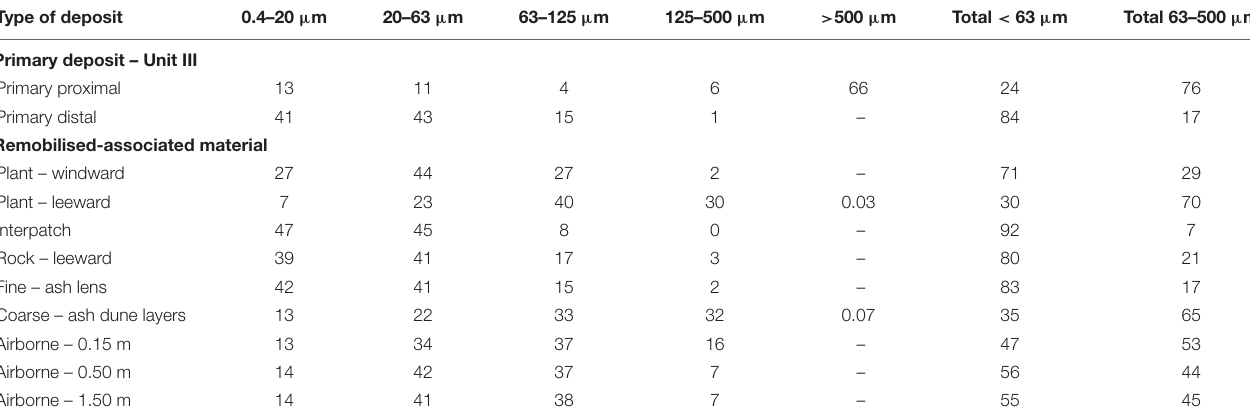
TABLE 3 | Averaged volume percentage (%) per grainsize class for primary tephra-fallout deposit and remobilised samples. Type of